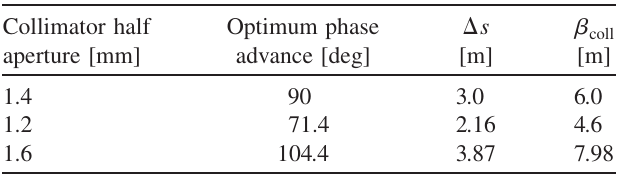
TABLE II. CS optics parameters for different half apertures needed to restore the unity collimation